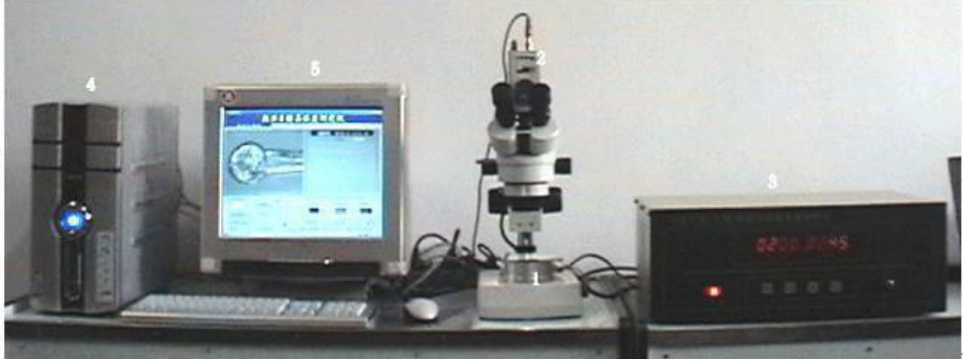
Figure 1. Photo of a typical SHTT Ⅱ experimental